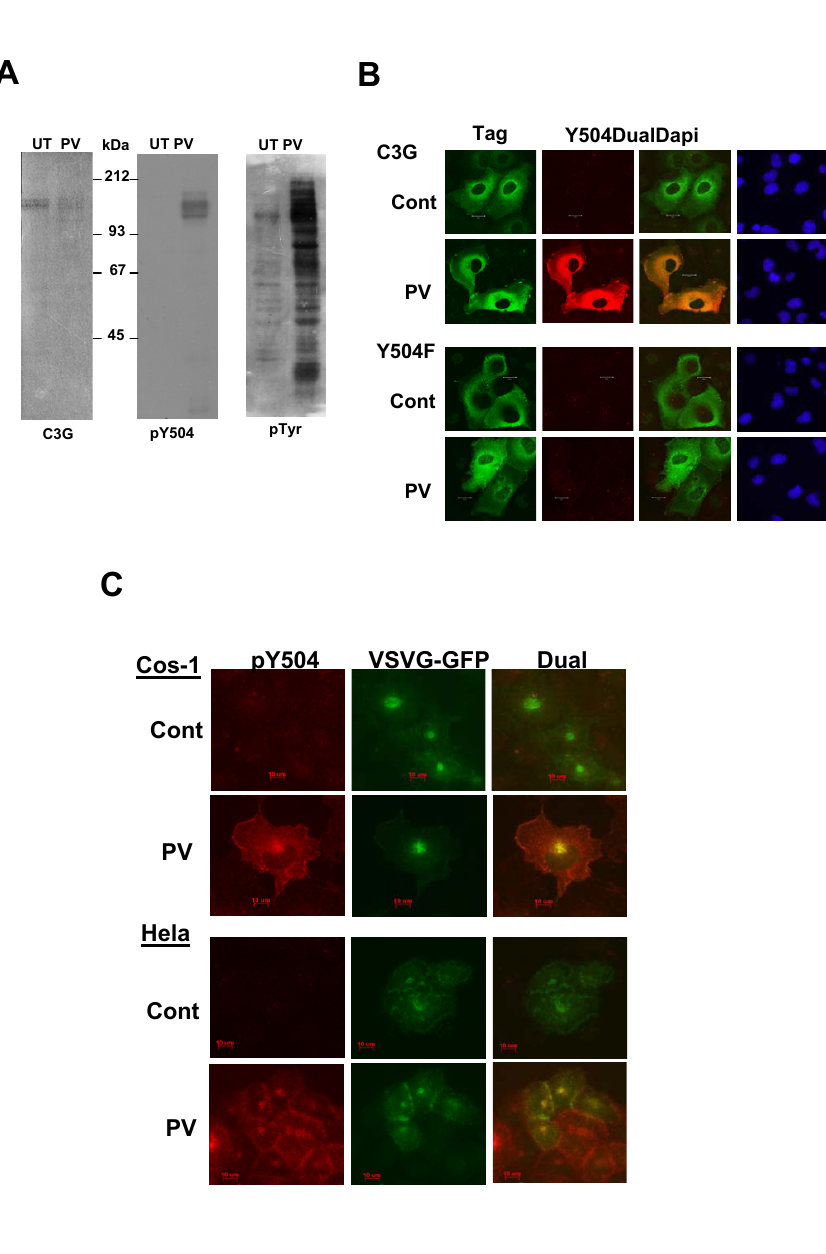
Figure 5 Phosphorylation of endogenous C3G upon activation of endogenous tyrosine kinases. (A) Cells were either left untreated (UT) or treated with pervanadate (PV) and western blotting was performed using pY504 antibody. The same blot was reprobed with C3G to show the presence of endogenous C3G in these cells. (B) Cos-1 cells on coverslips were trans- fected with either C3G or Y504F mutant of C3G and fixed without any treatment (cont.) or after pervanadate treatment (PV). Dual labeling was performed using the tag antibodies (stained with FITC) and pY504 antibody (stained with Cy3). Panels show optical sections obtained by confocal microscopy. (C) Cos-1 and HeLa cells grown on coverslips and transfected with VSVG- GFP were fixed without any treatment (control) or after treatment with pervanadate and stained for pY504 expression. GFP fluorescence was used to visualize the staining pattern of VSVG-GFP protein. Optical sections taken using the apotome are shown. Areas of colocalization are seen from the yellow color generated in the merged